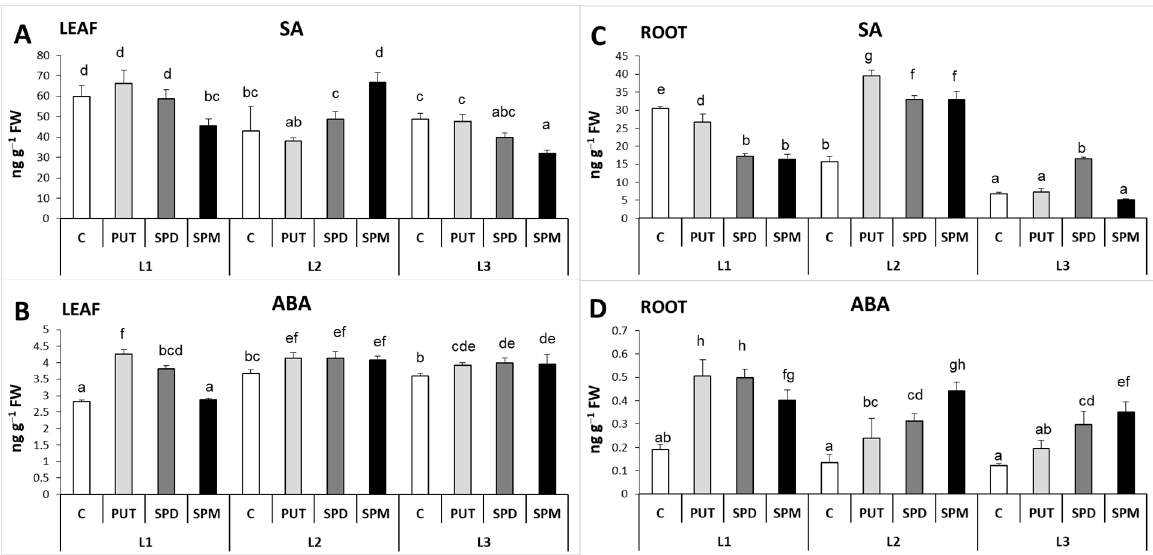
Figure 10. Effect of different light intensities on the salicylic acid (SA) ( A , C ) and abscisic acid (ABA) ( B , D ) content in the leaves ( A , B ) and roots ( C , D ) of plants grown under 16 h/8 h day/night light period with different light intensity conditions: 500 (elevated light: L1), 250 (medium light: L2) and 50 (lower light: L3) µ mol m 2 s − 1 LED light after 7 days of 0.3 mM exogenous putrescine (PUT), spermidine (SPD) or spermine (SPM) treatments or without any treatment (C). Data represent mean values ± SD. Different letters indicate significant differences at p ≤ 0.05 level, among all the values of the given